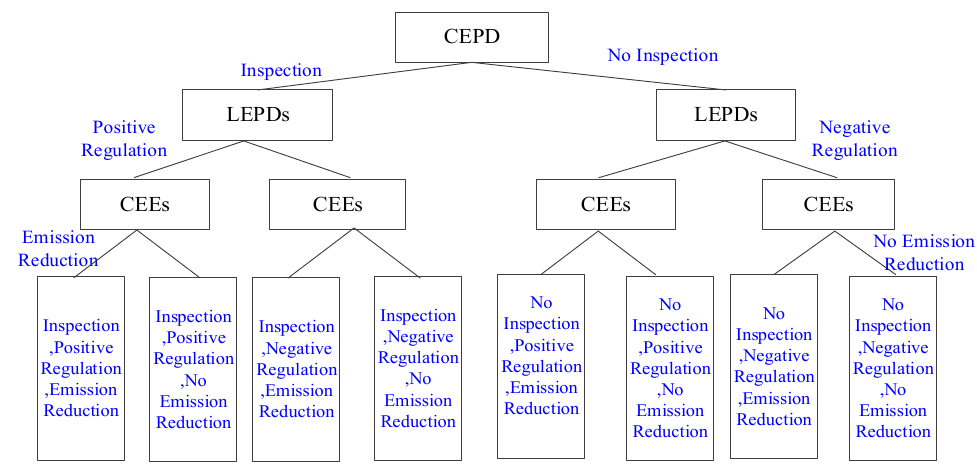
Figure 1. Multi-agent game strategy.